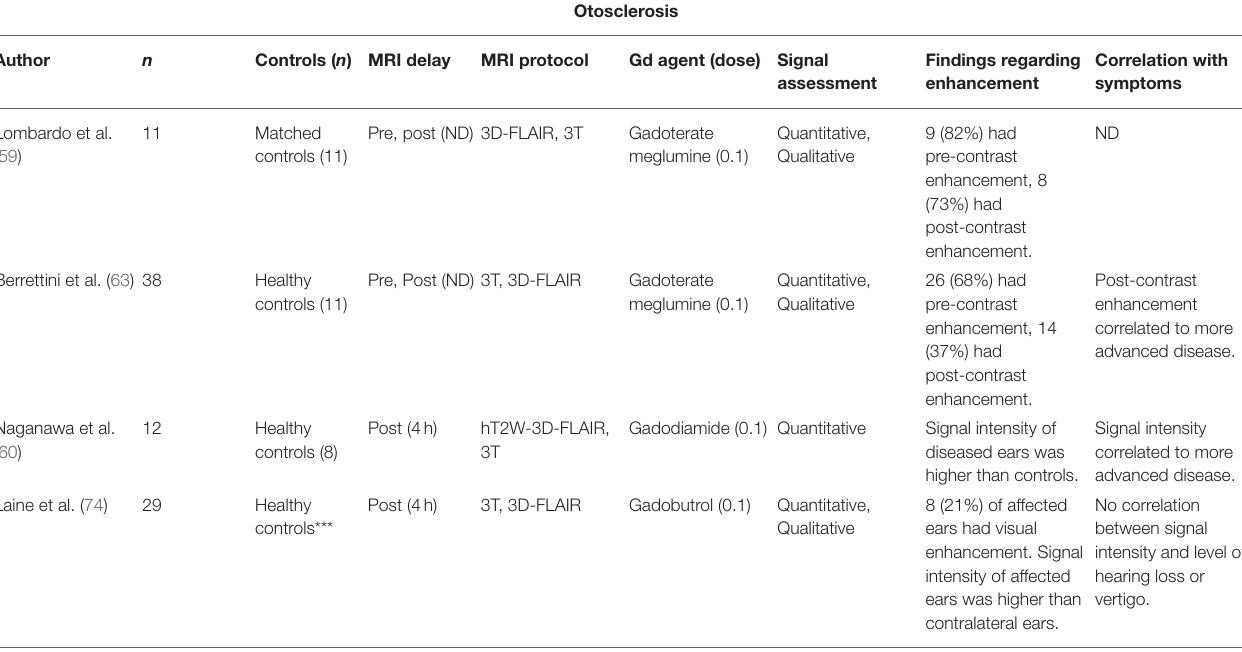
TABLE 6 | Summary of findings in studies of